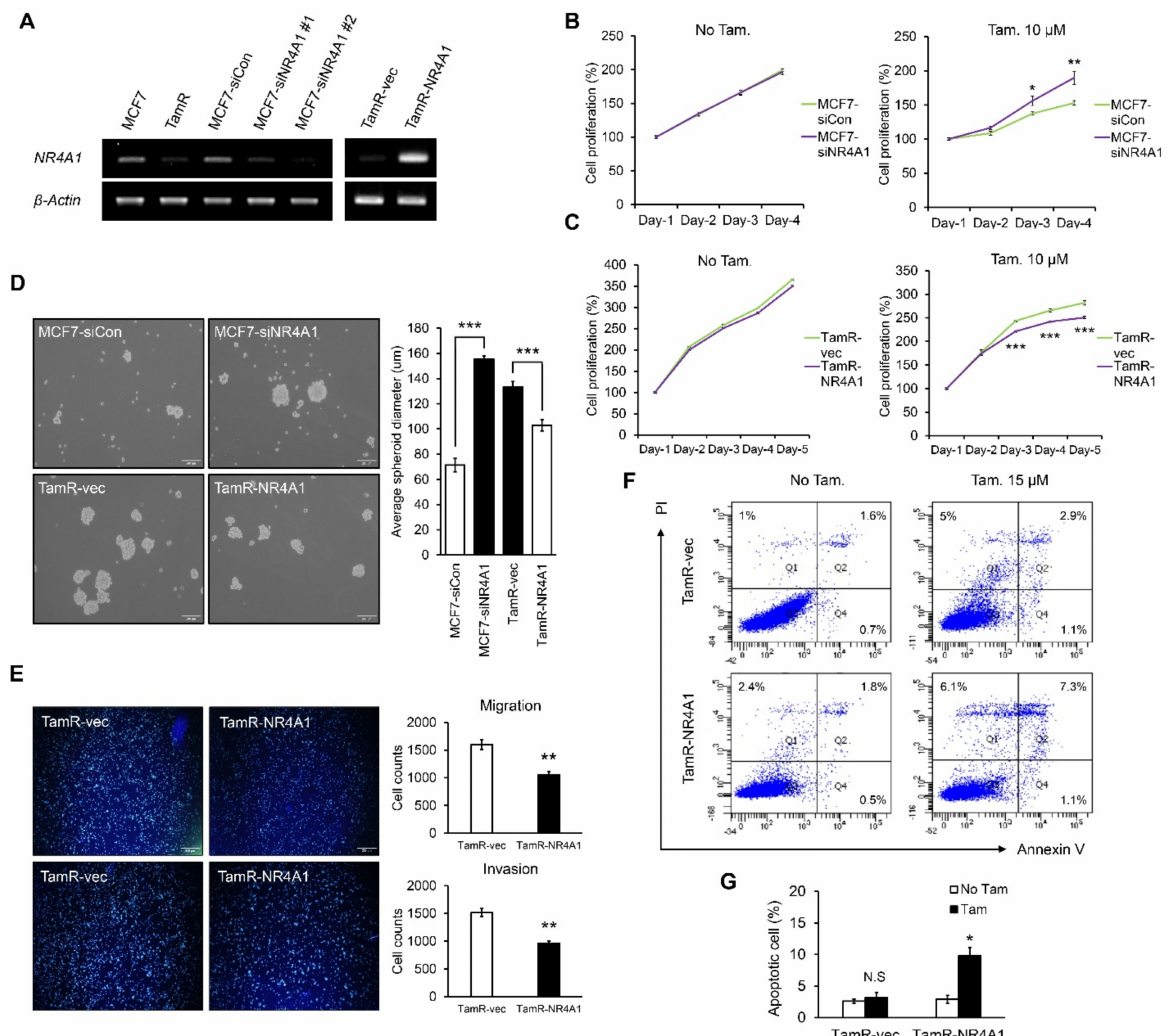
Figure 2. NR4A1 suppresses proliferation, migration, and invasion, while increasing tamoxifen-induced apoptosis in TamR cells. ( A ) mRNA expression levels of NR4A1 in MCF7, TamR, MCF7 cells transfected with siControl (siCon) or NR4A1 siRNA (siNR4A1), and TamR cells transfected with pcDNA3 (empty vector) or pcDNA3-NR4A1. ( B ) Cell proliferation curves of siCon/siNR4A1 MCF7 cells untreated (No Tam.) or treated with 10 µ M tamoxifen (Tam.) for 4 days. ( C ) Cell proliferation curves of TamR-vec and TamR-NR4A1 cells untreated (No Tam.) or treated with 10 µ M tamoxifen (Tam.) for 5 days. ( D ) Representative images of breast cancer spheroids growth of MCF7 cells transfected with siCon or siNR4A1, and TamR cells transfected with empty vector or pcDNA3-NR4A1 (left panel). Spheroid formation was analyzed after 6 days. Quantification of average spheroid diameter (right panel) is represented on a bar graph. ( E ) Matrigel invasion and migration assays in empty vector transfected TamR and stable NR4A1-overexpressing TamR cells. Migrating and invasive cells stained with DAPI were calculated using imageJ. ( F ) FACS analysis of apoptotic cell death in TamR-vec and TamR-NR4A1 cells untreated or treated with 15 µ M tamoxifen. Apoptotic cells were stained by Annexin V/PI. ( G ) Percentage of apoptotic cells from ( F ) are represented on a bar graph. * p < 0.05, ** p < 0.01, and *** p <